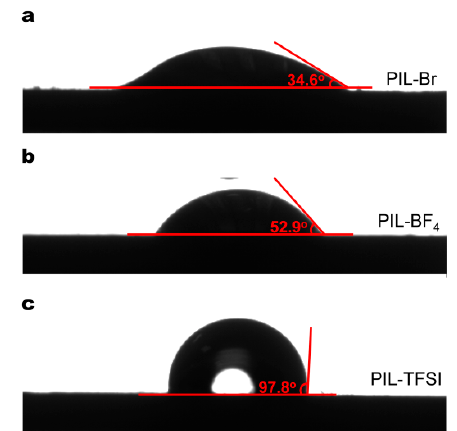
Figure 3. Static water contact angles corresponding to the as-prepared poly(ionic liquid)s (PILs): ( a ) PIL-Br, ( b ) PIL-BF 4 and ( c ) PIL-TFSI.